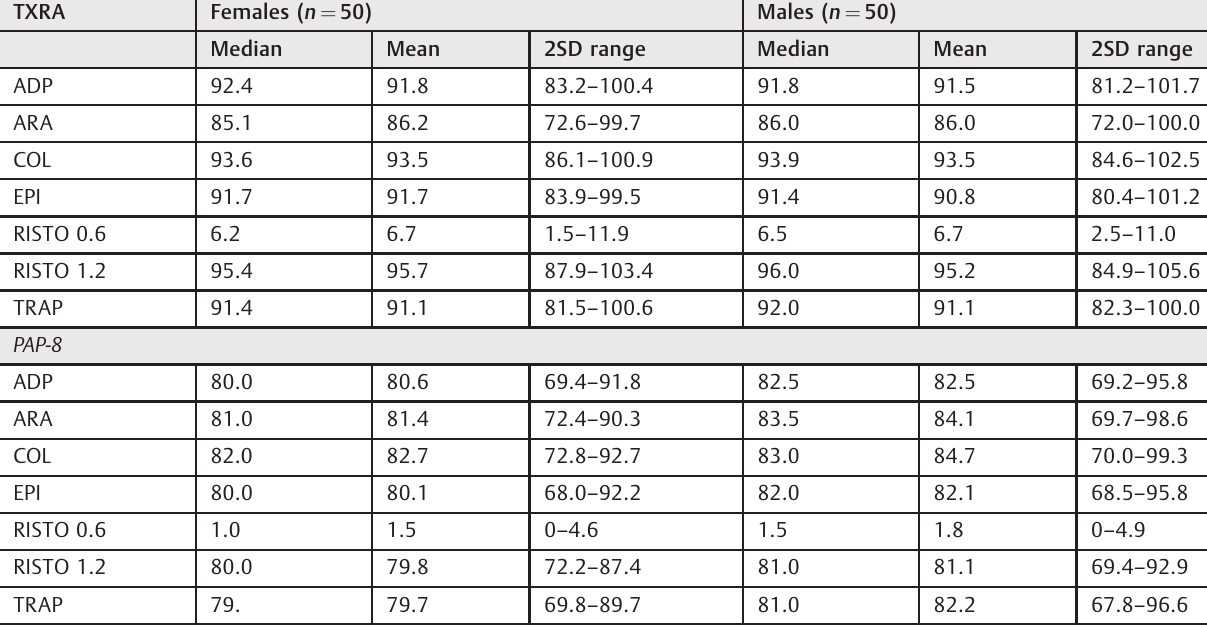
Table 3 Reference ranges for MA%. Gender-speci fi c normal ranges (TXRA, against PPP)